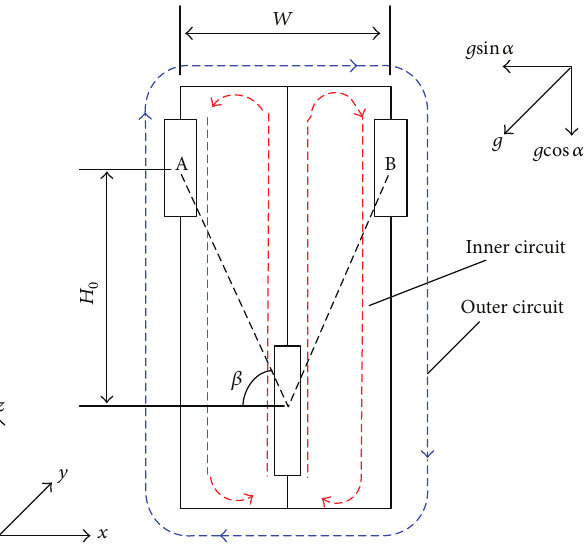
Figure 11: Mechanism of disparity of natural circulation ability.